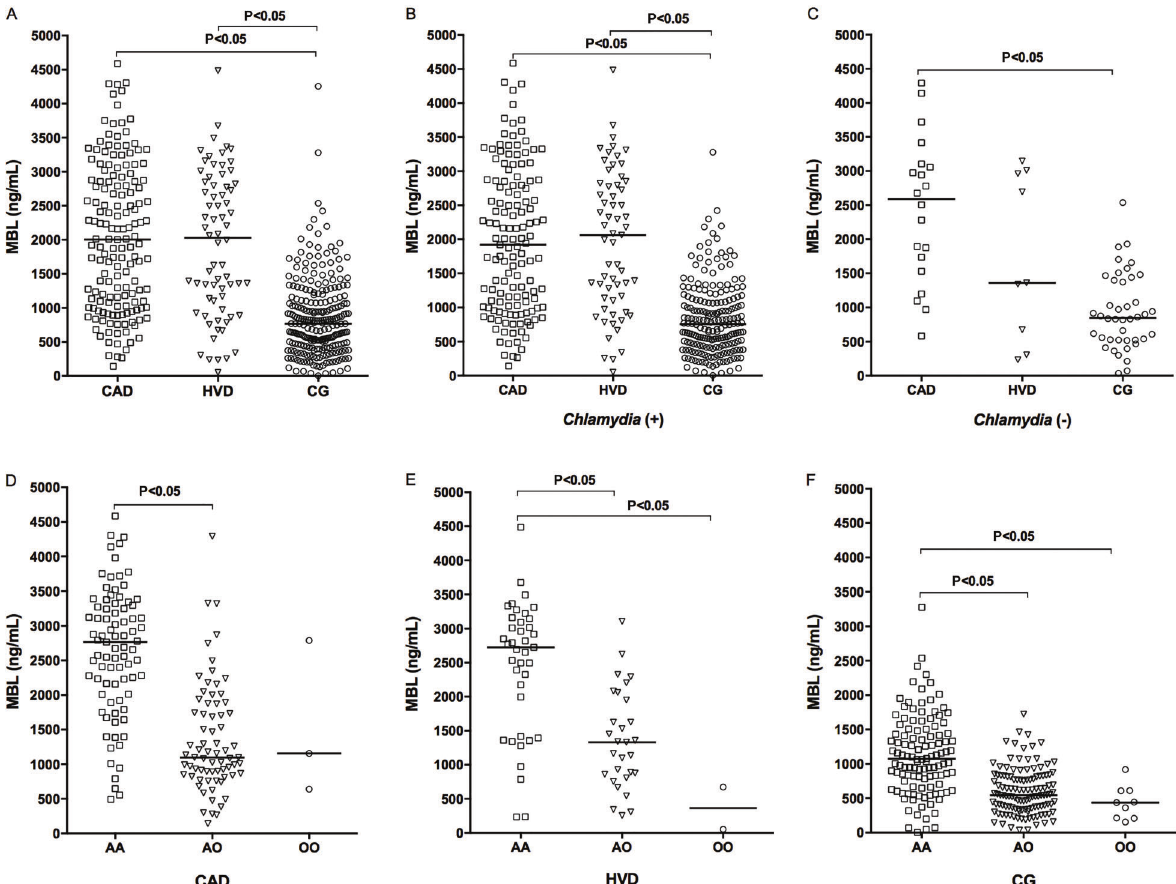
Figure 1. Distribution of mannose-binding lectin (MBL) plasma levels in patients with coronary artery disease undergoing coronary artery bypass surgery (CAD), patients with heart valve disease undergoing valve replacement (HVD), and the control group (CG) ( A ); among the three groups with positive ( B ) and negative serology ( C ) for Chlamydia, and in relation to the different genotypes of each group ( D , E , and F ). Data are reported as medians (Kruskal-Wallis and Mann-Whitney